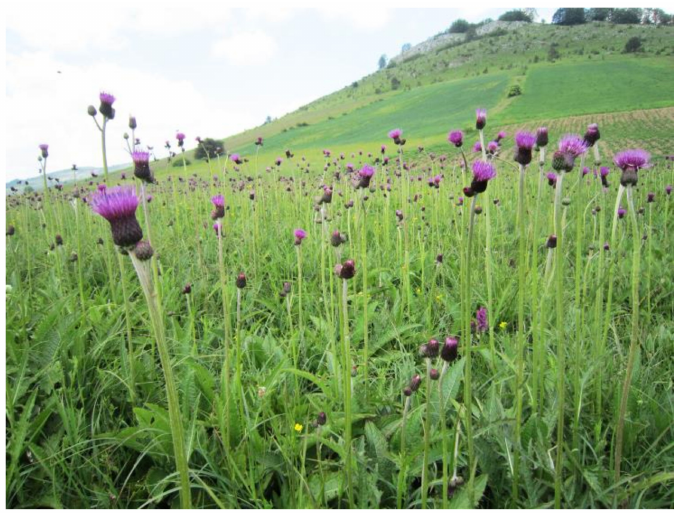
Figure 11. The association Cirsietum rivularis Nowi´nski 1927 (Serbia, photo V.